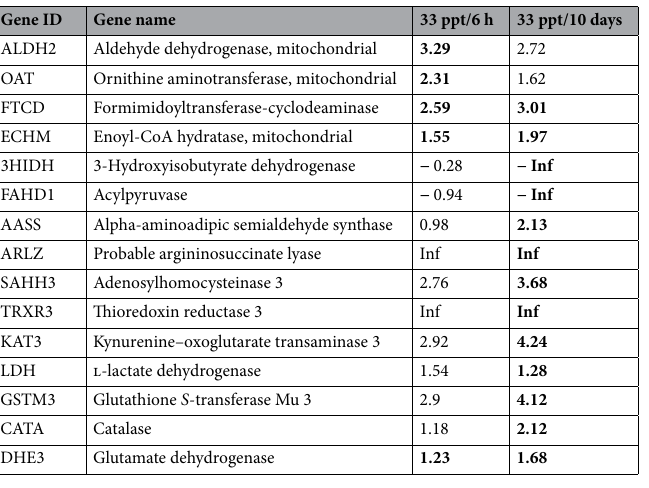
Table 4. Log2 fold change of differentially expressed proteins of interest in 33 ppt groups. Significant differences (FDR < 0.05) are in